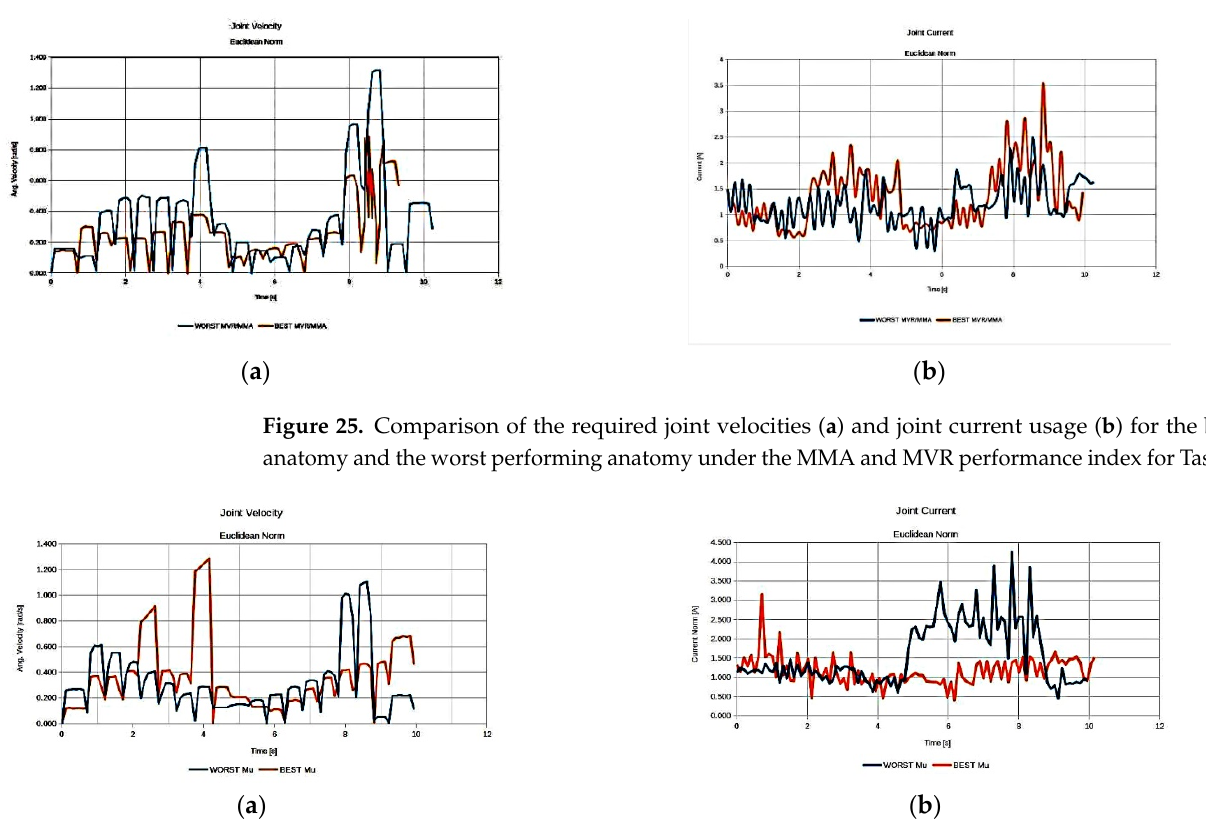
Figure 27. Optimal anatomy of the metamorphic manipulator derived under the effective mass measure for Task 4.